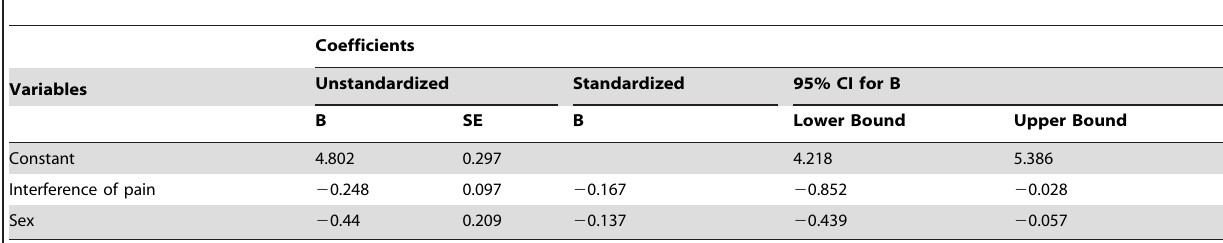
Table 4. Regression model for patient characteristics and clinical outcomes as predictors of